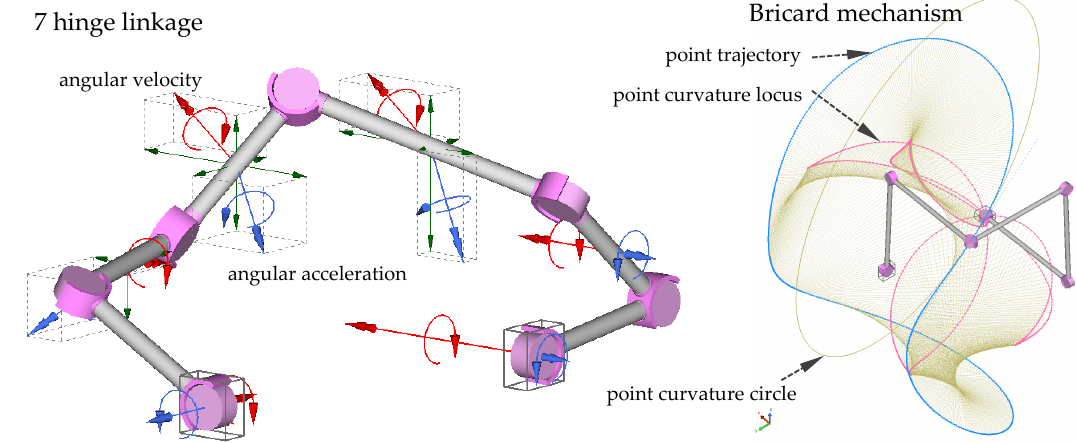
Figure 9. Angular velocities and accelerations. Loci of center of curvature of a trajectory.